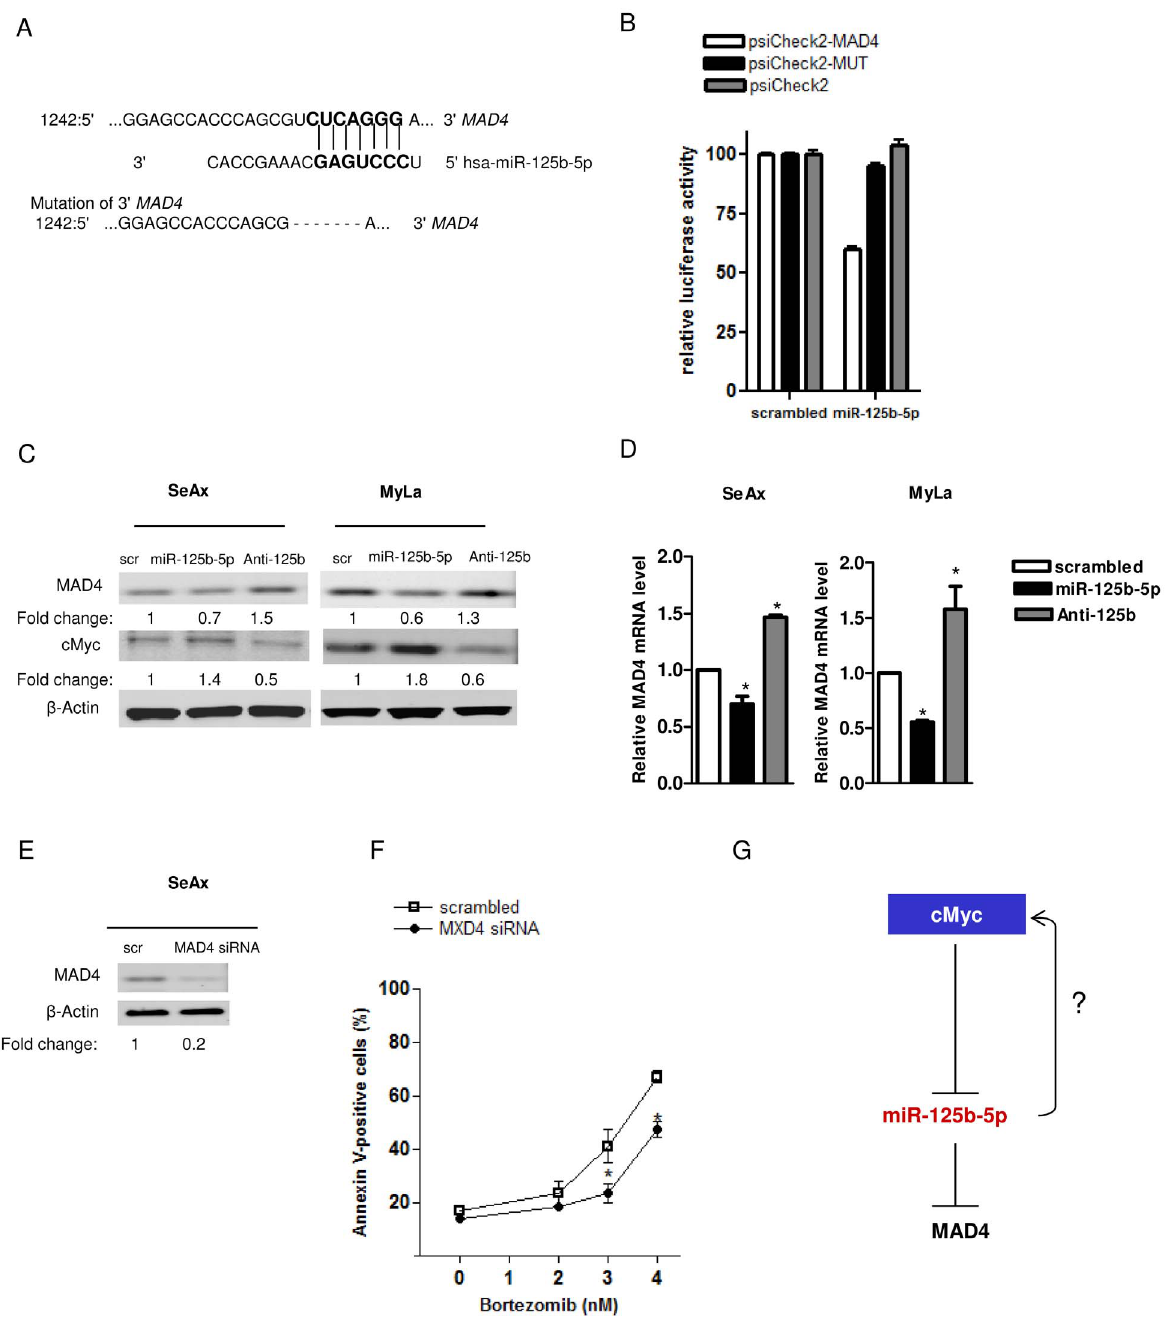
Figure 4. MAD4 is a direct target of miR-125b-5p. (A) The miR-125b-5p responsive element in MAD4 gene 3 9 UTR and the base-paired to miR- 125b-5p are showed on the top row of the schematic diagram. The psiCheck2 reporter constructs containing the MAD4 3 9 UTR (top row) or the mutated one (obtained by deleting the seed sequence of miR-125b-5p as shown in the lower row of the schematic diagram) were assayed. (B) Luciferase reporter assay (taken after 24h transfection in Hek-293 cells) showing that miR-125b-5p represses the luciferase activity of the reporter construct containing the MAD4 responsive element (psiCheck2-MAD4). Deletion of the miR-125b-5p responsive element in the MAD4 3 9 UTR (psiCheck2-Mut) rescued the luciferase activity. Renilla luciferase activities were normalized to the values of the internal Firefly and to the scrambled transfection control. (C) Detection of the MAD4 and cMyc protein levels in CTCL cells (SeAx and MyLa) after miR-125b-5p overexpression or downregulation. b -actin was the loading control and protein changes are showed as in Figure 1A. (D) Changes in the relative MAD4 mRNA level detected by qRT-PCR in CTCL cells. (E) Evaluation of the efficient MAD4 silencing in SeAx cells by Western Blot. (F) Decrease of the percentage of the annexin-V positive cells after MAD4 silencing in SeAx cells treated with bortezomib (48h) comparing to scrambled siRNA. (G) A mechanistic model describing the regulative loop involving cMyc and miR-125b-5p in cell resistance to bortezomib. cMyc induces the transcriptional inhibition of miR- 125b-5p that directly inhibits MAD4 and induces cMyc accumulation. All quantitative data are shown as mean 6 SD (* P , 0.05).